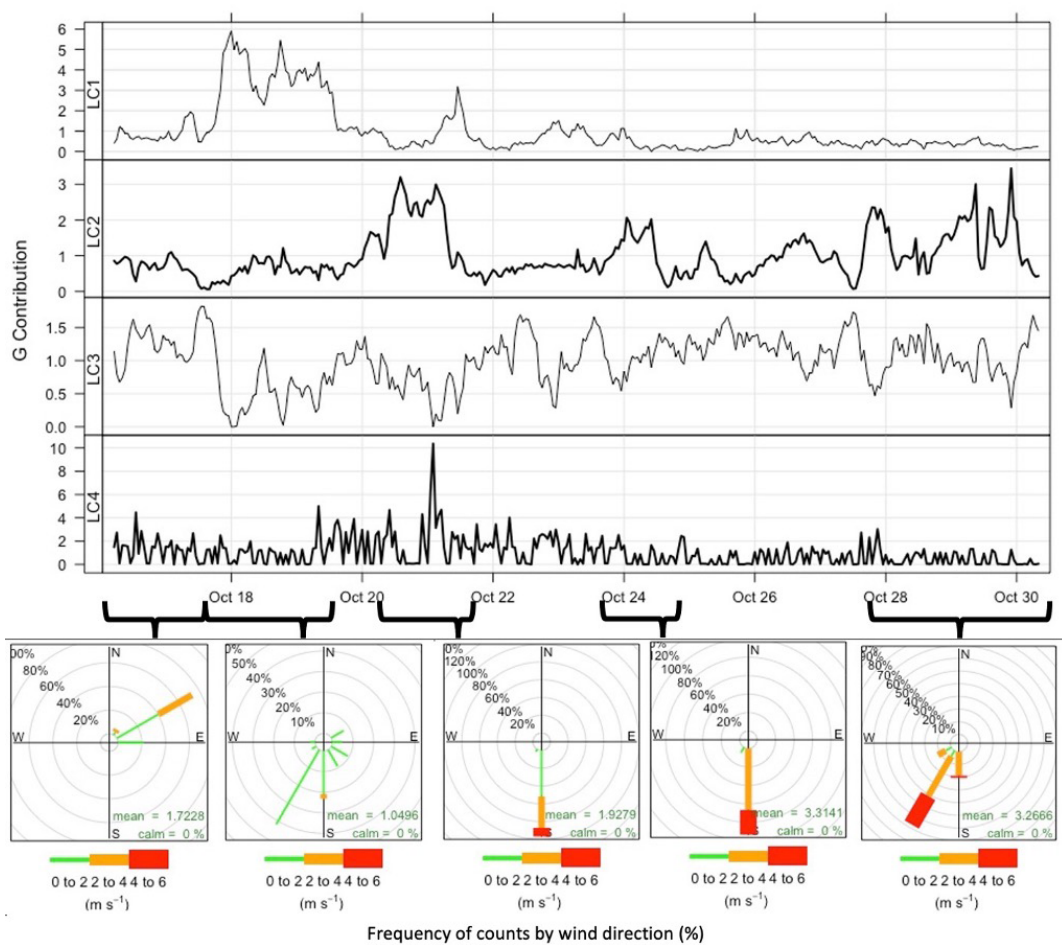
Figure 4. Temporal variation of the contributions of the factors from the LC analysis. The wind roses refer to the wind conditions for the corresponding periods when specific factors presented higher G